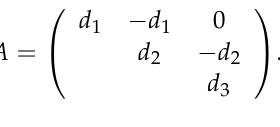
, A − , A − Left Middle Right